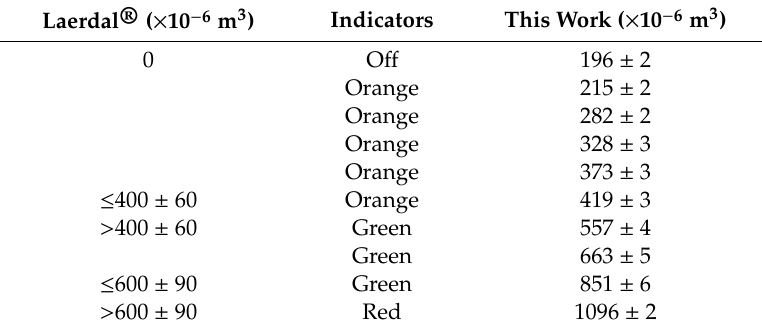
Table 6. Simultaneous measurements of the Laerdal ® and YF-S201